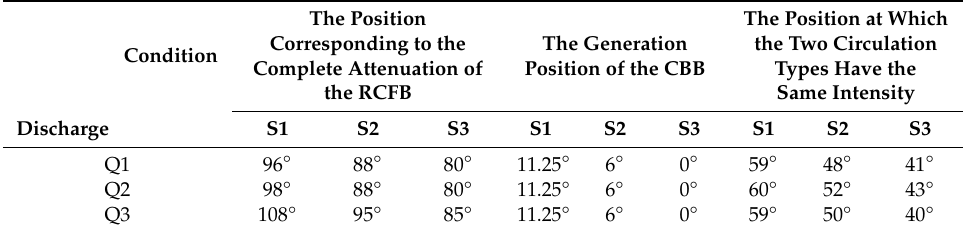
Figure 6. Variation in circulation structure size along the back bend: ( a ) Variation in circulation structure size at Q1, ( b ) Variation in circulation structure size at Q2, ( c ) Variation in circulation structure size at Q3. F of the legend denotes the Residual Circulation of the Front Bend (RCFB) in the back bend, and B of the legend denotes the Circulation of the Back Bend (CBB) in the back bend. The grey dotted line is the trend line after removing the out-bank cell. The size of circulation structure here is defined as the area occupied by circulation. Table 3. Development of the two kinds of circulations in the back